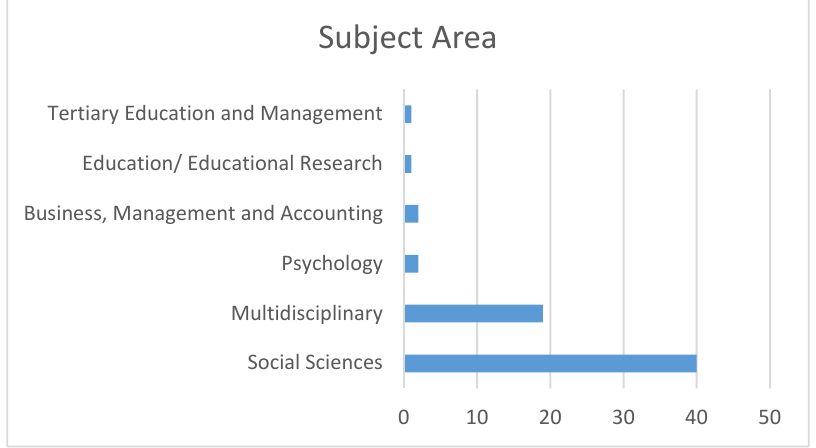
Figure 4. Studies subject area.